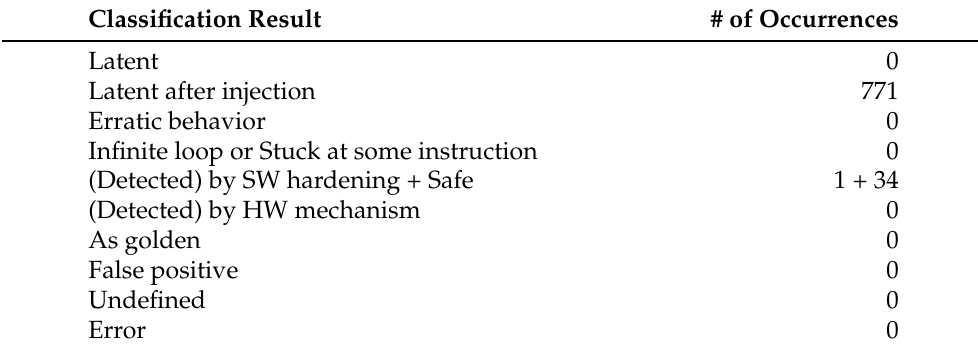
Table 6. Classifier results obtained from the fault injection campaign assessing the RACFED algorithm implemented on tank